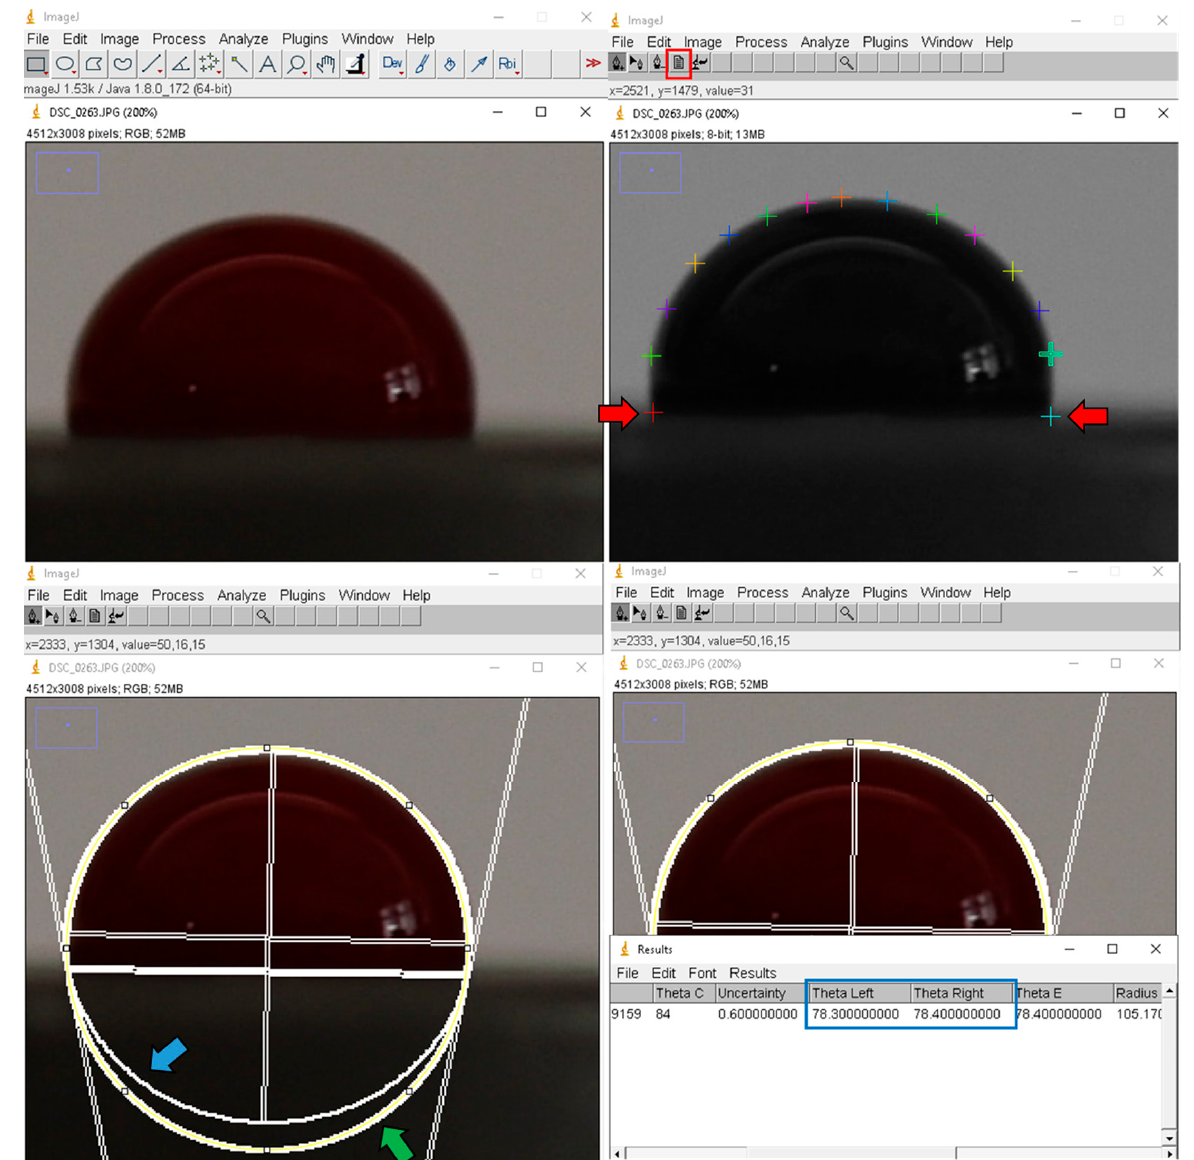
Figure 3. Contact angle measurement with ImageJ’s Contact Angle plugin. Following the manual selection of the first 2 points ( red arrows ) to determine the baseline, the periphery of the blood sample was marked to calculate the contact angle between the surface and blood. It is important to point out that an ellipse best-fit analysis poses itself between the circle best fit ( green arrow ) and an absolute best-fit function. Sometimes the drop is not perfectly symmetric or there is a slight effect due to gravity. In this case, an almost-circle ( blue arrow ) analysis can provide useful results.